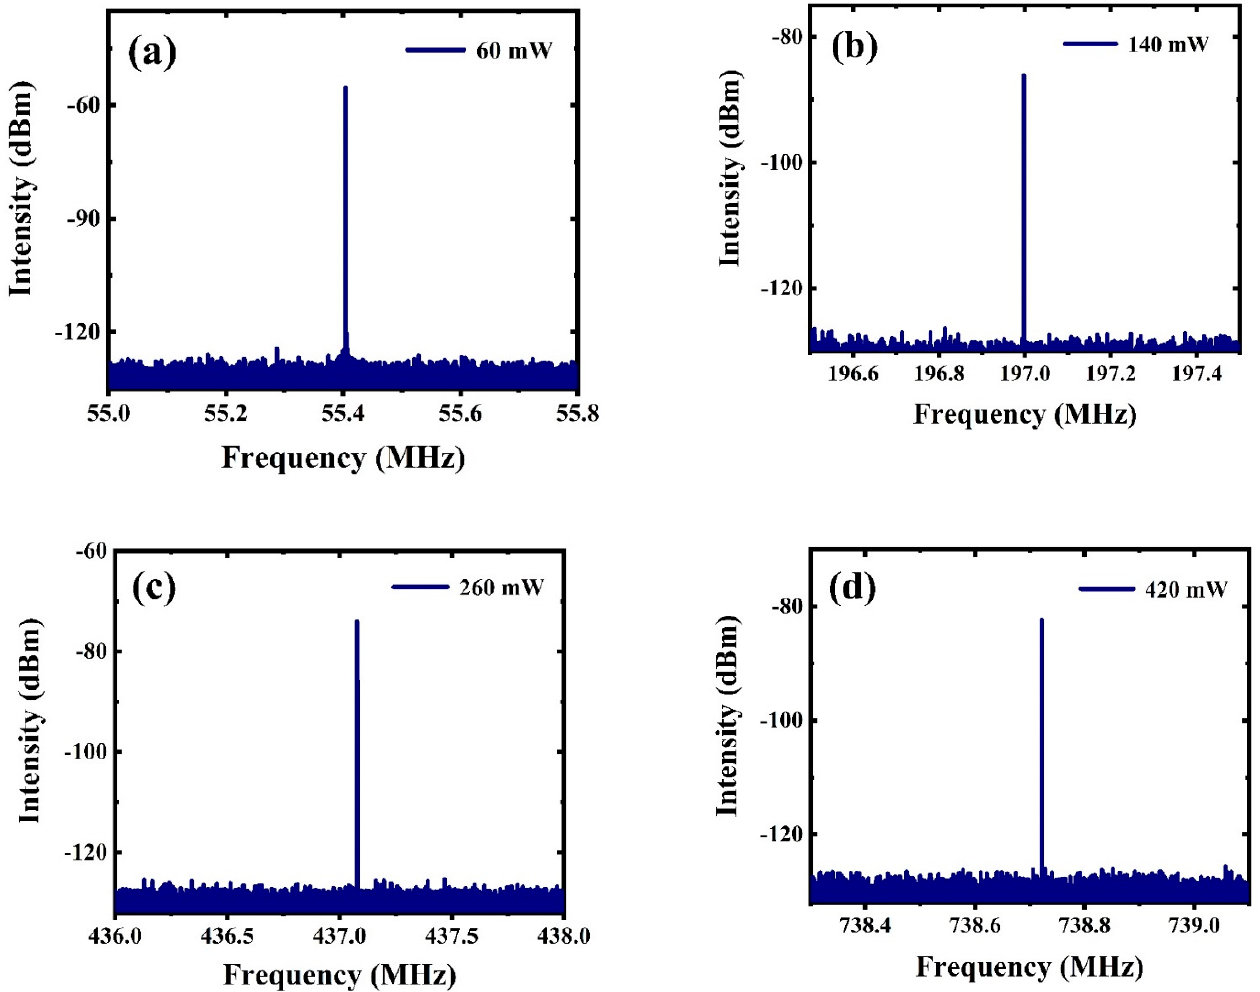
Figure 5. RF spectra of harmonic output pulses at 60 mW ( a ), 140 mW ( b ), 260 mW ( c ), and 420 mW ( d ).